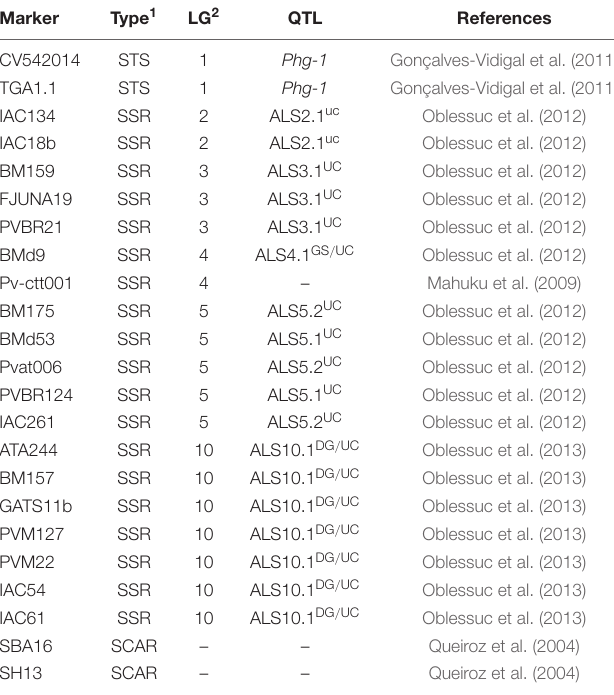
TABLE 1 | Molecular markers previously associated with angular leaf spot resistance QTL used for the genotyping of the AM population (91 BC 2 F 3 ).